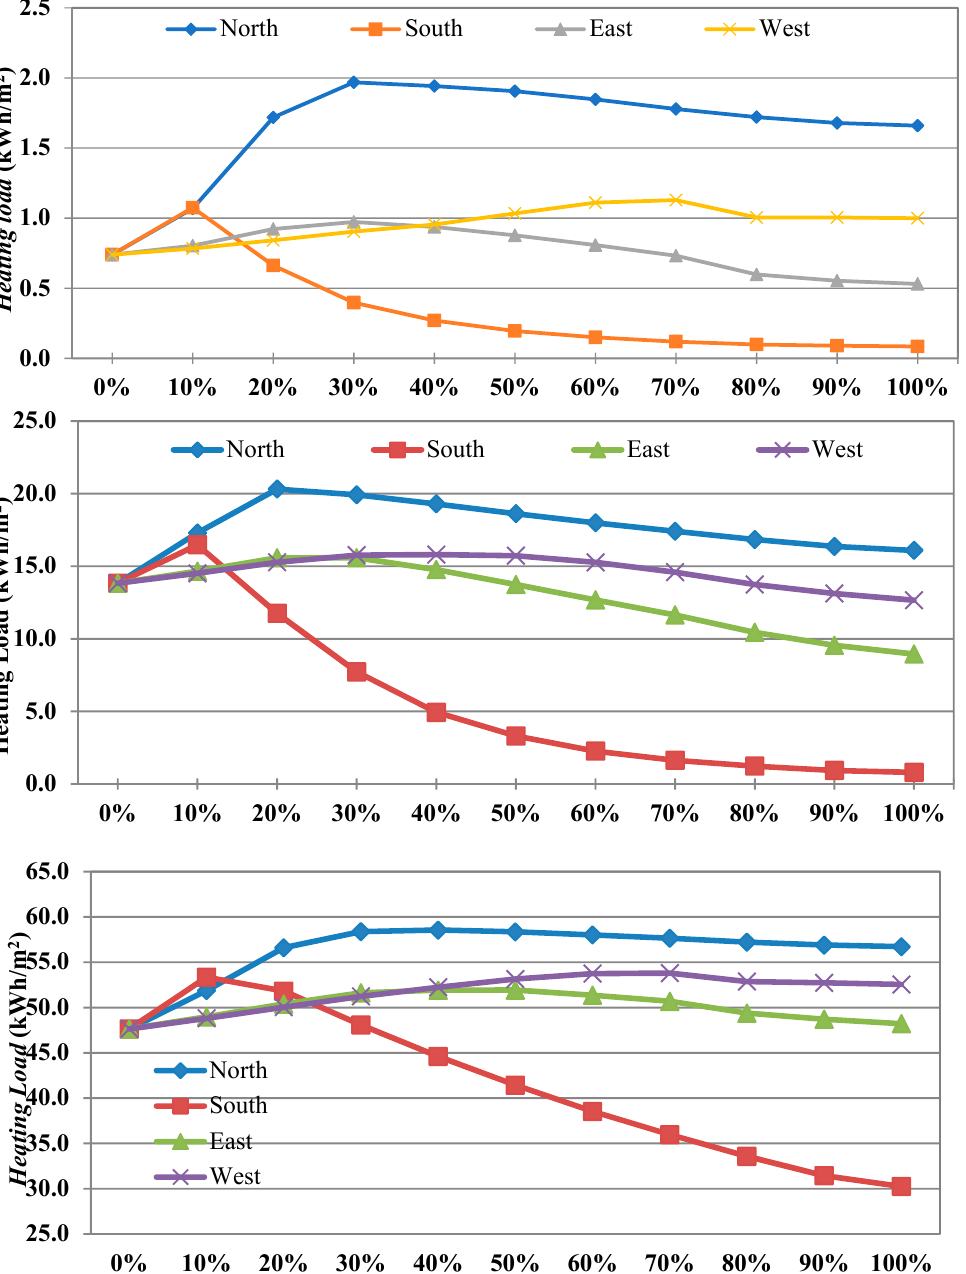
Figure 6. Annual heating load of buildings with different percentages of windows at different facades for Bushehr (upper), Shiraz (middle), and Tabriz (below), Iran.